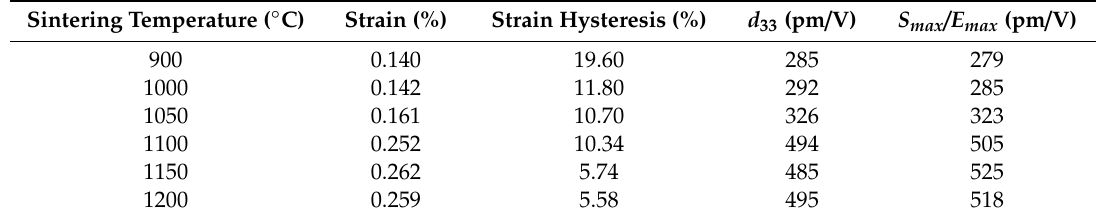
Table 5. Piezoelectric properties of microwave sintered PLZT 8 / 60 / 40 ceramics measured at 50 kV / cm. Sintering Temperature ( ◦ C)